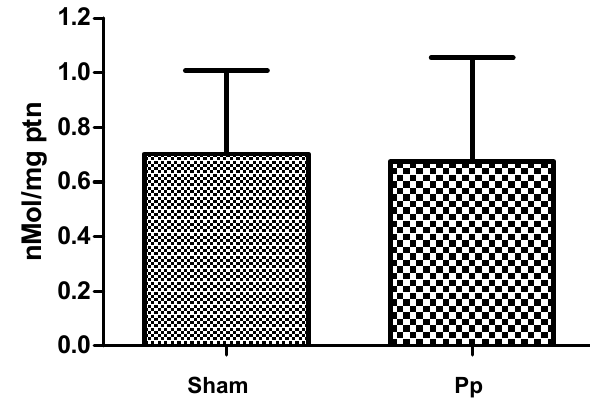
Figure 3 - Protein carbonyl concentration in renal tissue of rats submitted to 8 mmHg pneumoperitoneum for 3 hours. The bars represent men and standard deviation. The means are not significantly different (t test,